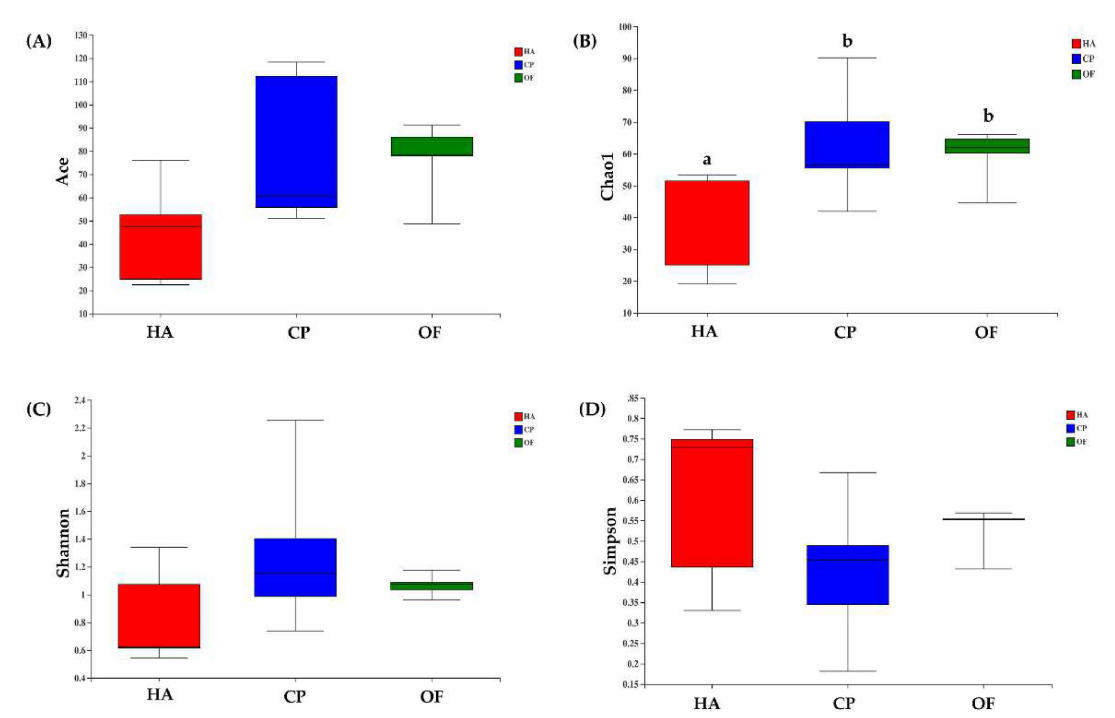
Figure 1. Box plots of ( A ) ACE, ( B ) Chao, ( C ) Shannon and ( D ) Simpson values of bacterial diversity in larval gut samples. Abbreviations in the figure are given following the scientific names of insects: HA, H. armigera ; CP, C. punctiferalis ; OF, O. furnacalis . Letters above each group indicate significant differences ( p < 0.05) in the mean